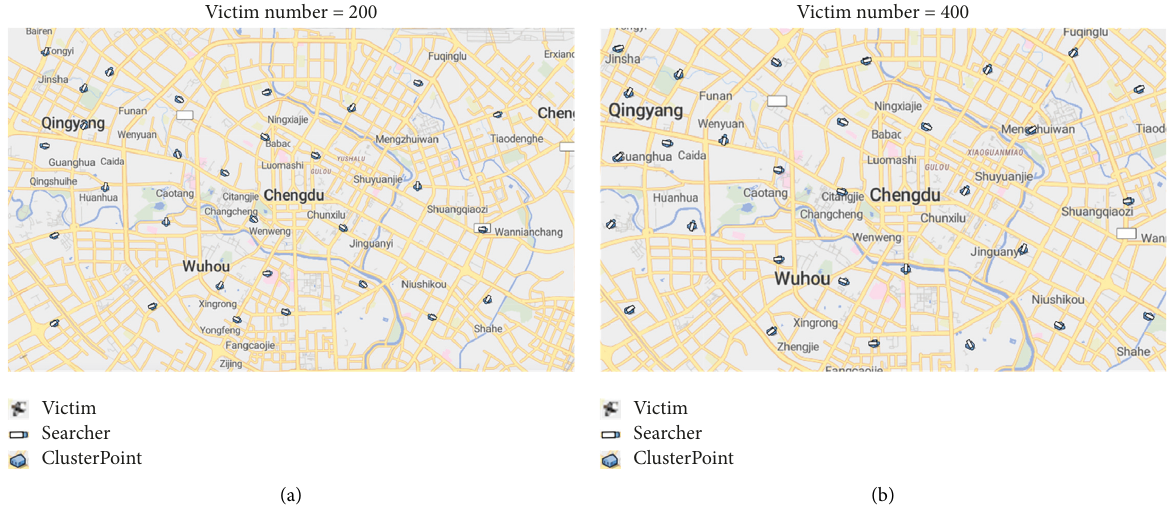
Figure 10: The result of experiment victims with speed (200 victims (a) and 400 victims (b)).